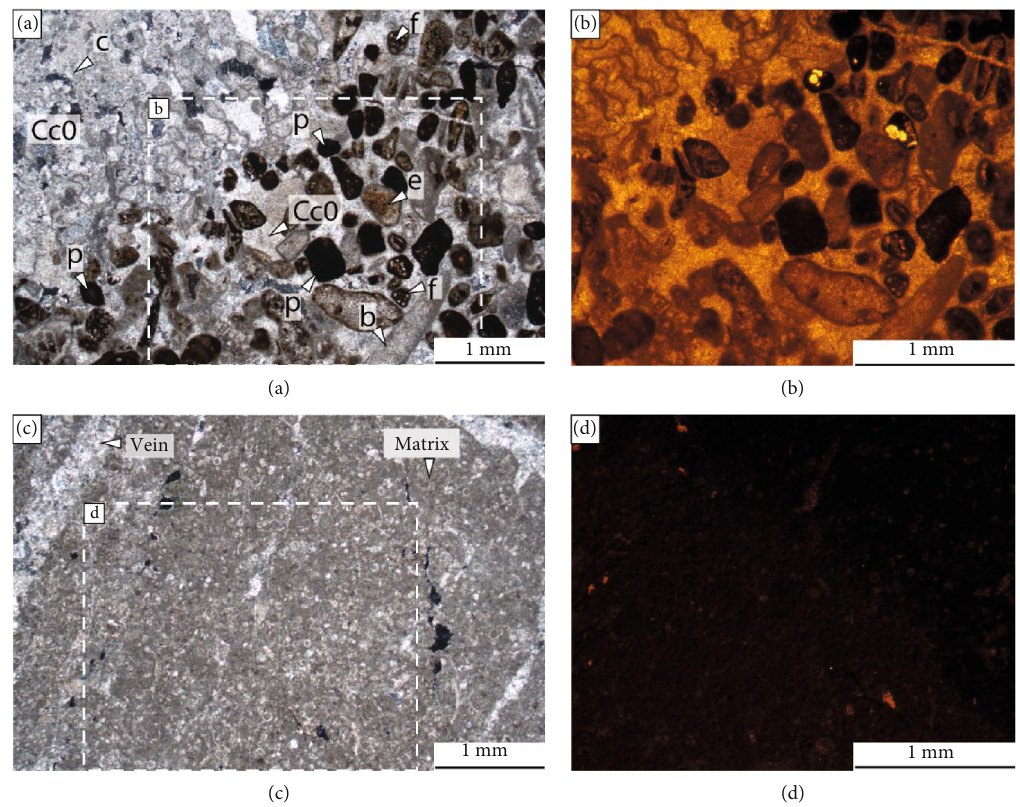
Figure 4: (a, b) Plane-polarized light and cathodoluminescence microphotographs of the footwall host rocks consisting of a grainstone made up of corals (c), foraminifers (f), bivalves (b), echinoids (e), and peloids (p), cemented by calcite (Cc0). (c, d) Plane-polarized light and cathodoluminescence microphotographs of the hanging wall host rocks composed of a wackestone of calcispheres and planktonic